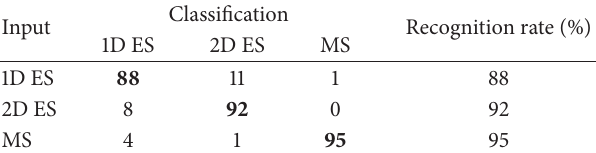
Table 1: Recognition